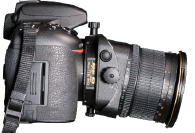
Figure 6: The Nikon D750 DSLR camera with the PC-E Micro NIKKOR 45 mm f/2.8D ED tilt-shift lens used in this paper. Model